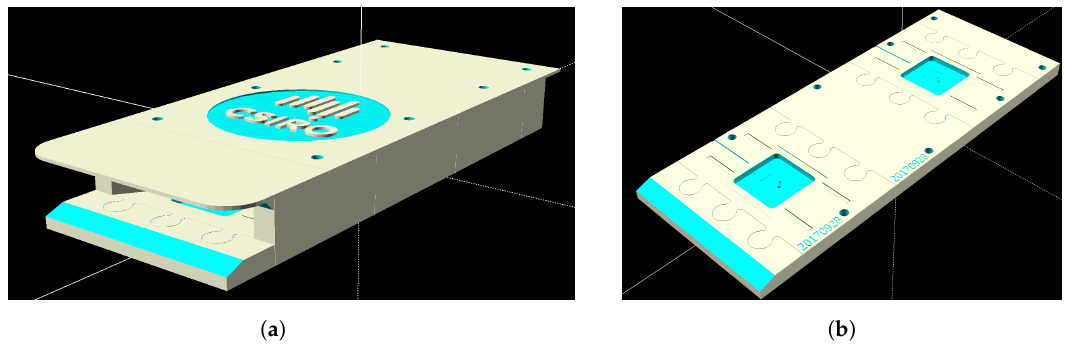
Figure 7. Model of a 3D-printed housing for the RFID patch antennas. This particular model has proven to be useful for Apis mellifera . Other bee species may require different arrangements. ( a ) External view of entrance housing. The structure is 38.5 cm × 12.5cm × 4cm; ( b ) Internal view of entrance housing. This is mirrored by the opposite layer of the housing to provide matching pairs of antennas. The centers of the highlighted squares (where the antennas are mounted) are 17cm apart.